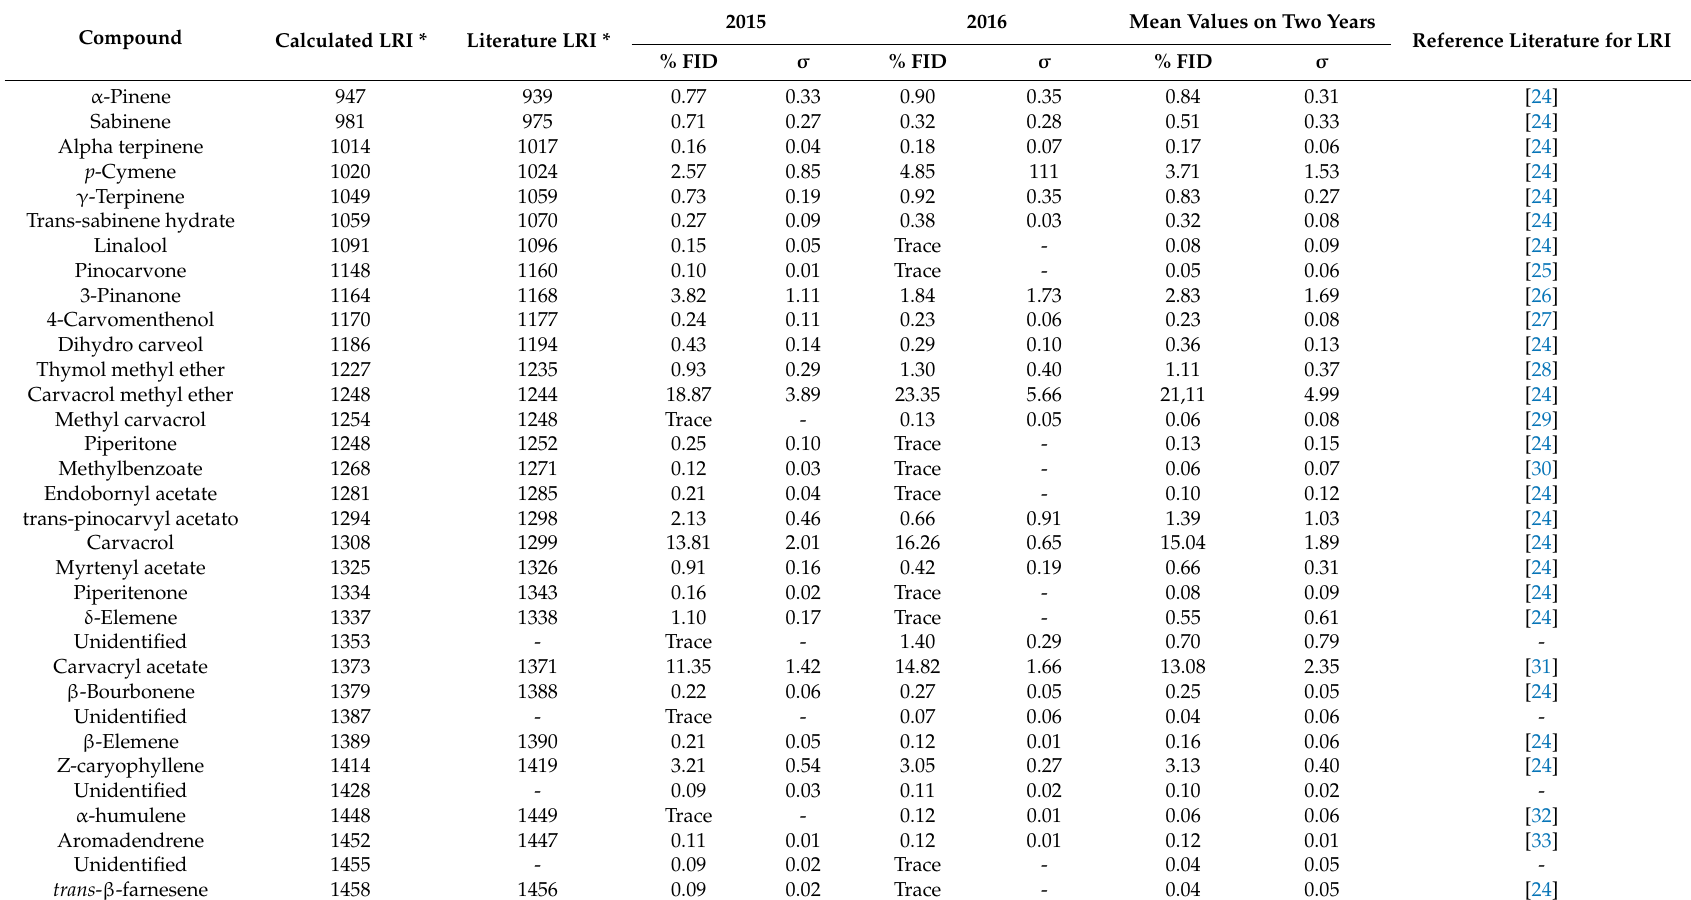
Table 1. Chemical composition of the essential oil distilled from C. taxifolium